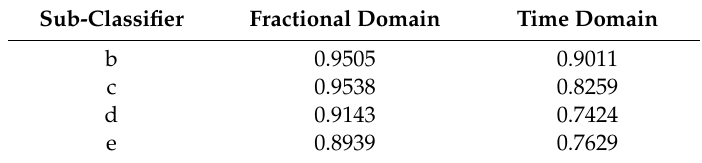
Table 9. Accuracy of each sub-classifier in fractional domain and time